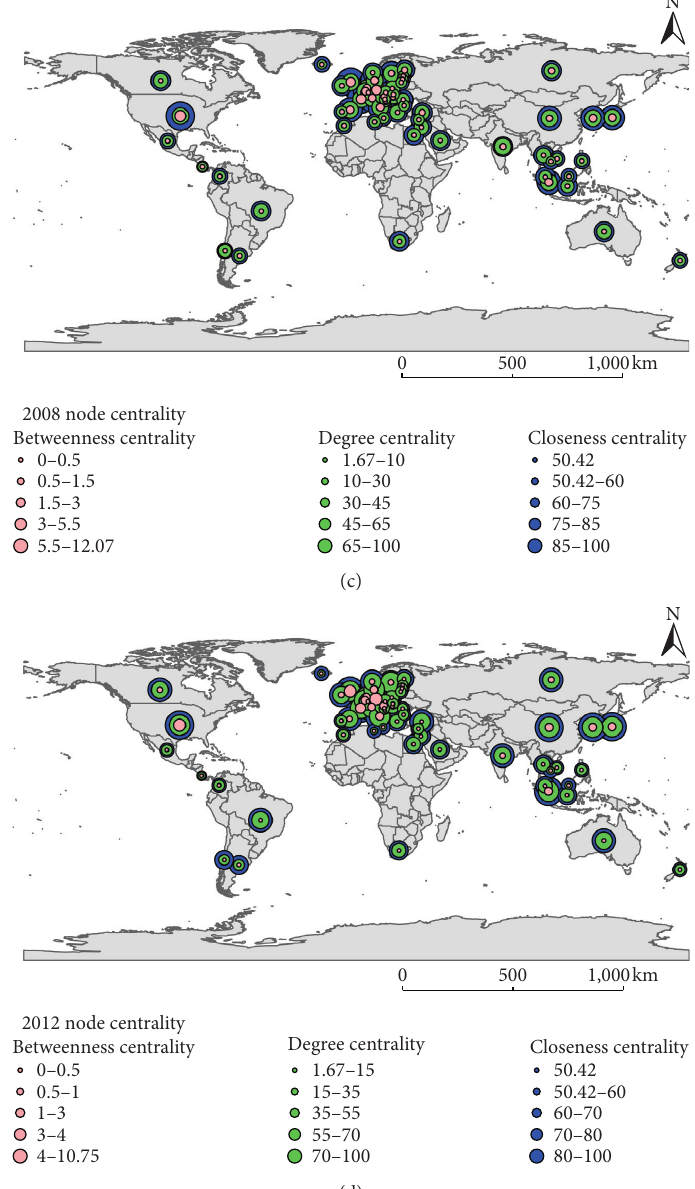
Figure 3: The evolution of centrality of the producer services trade